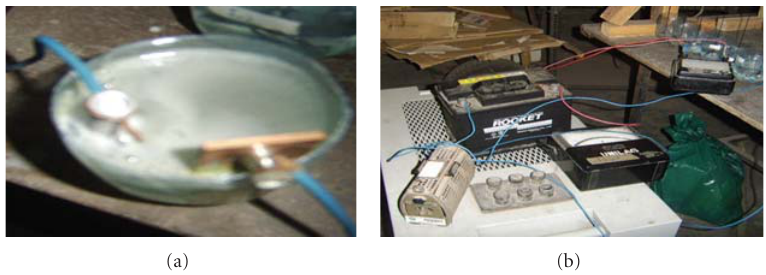
Figure 2: Electrochemical setup. Electrical measuring devices